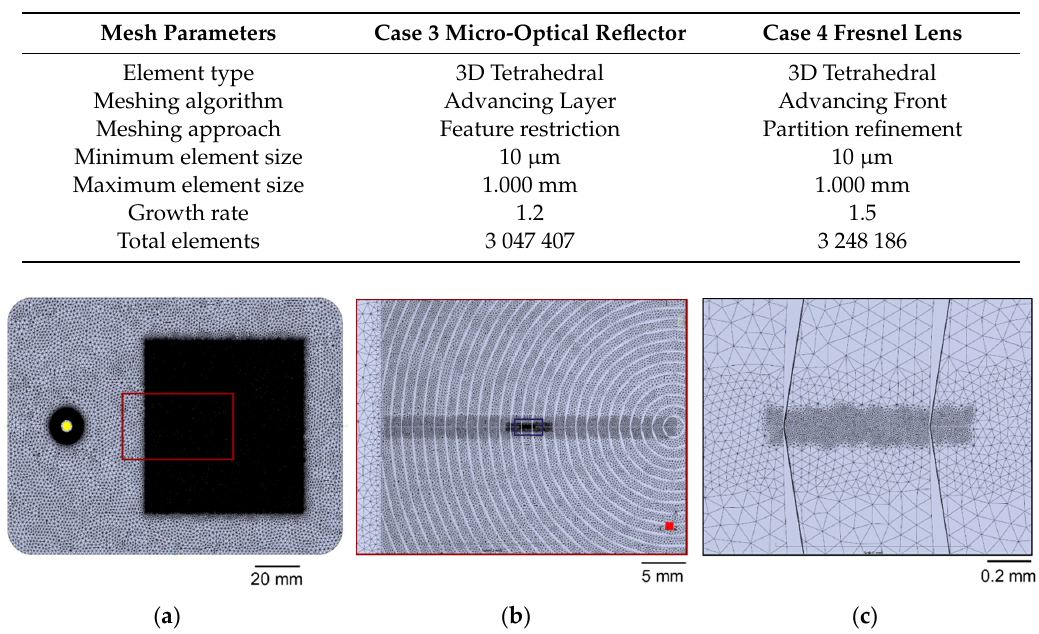
Table 4. Multi-scale meshing parameters for the micro-structured plastic parts.